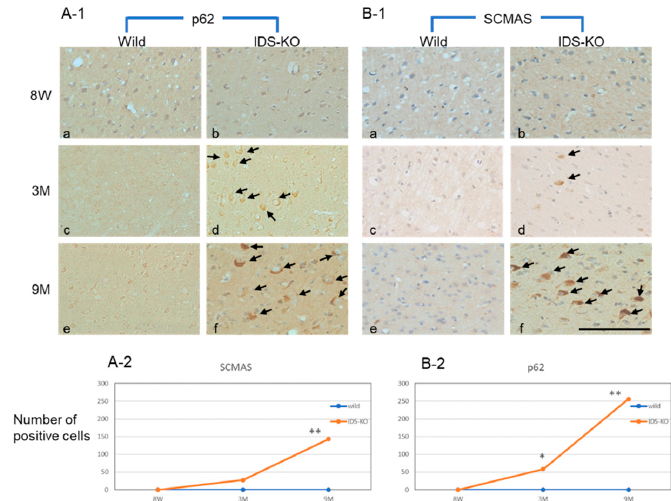
Figure 2. Immunostaining of P62 and subunit c of mitochondrial ATP synthetase (SCMAS) in the cerebral cortex. Immunostaining of P62 (A-1) and SCMAS (B-1) of specimens from wild-type (a, c, e) and IDS-KO (b, d, f) mice. Eight-week-old (8W) mice (a, b), three-month-old (3M) mice (c, d), nine-month-old (9M) mice (e, f). Arrows in A-1 and B-1 indicate p62-immunopositive cells and SCMAS-immunopositive neurons, respectively. Changes in the number of p62-positive cells (A-2) and SCMAS-positive cells (B-2) within 0.3 mm 2 of cortex over time. Bar = 100 μ m. * p < 0.05, ** p < 0.01, Welch’s t -test.